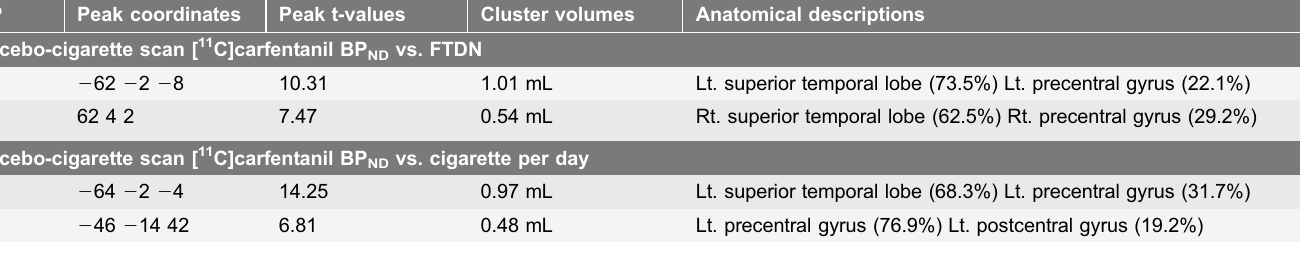
Table 4. Clusters of placebo-cigarette [ 11 C]carfentanil BP ND to current nicotine-dependence and smoking statuses correlations in smokers. N/P Peak